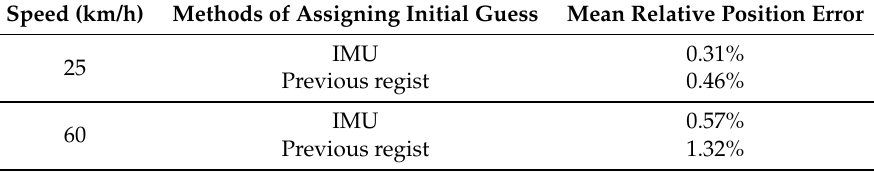
Table 3. Error comparison of different methods at the intermediate step.